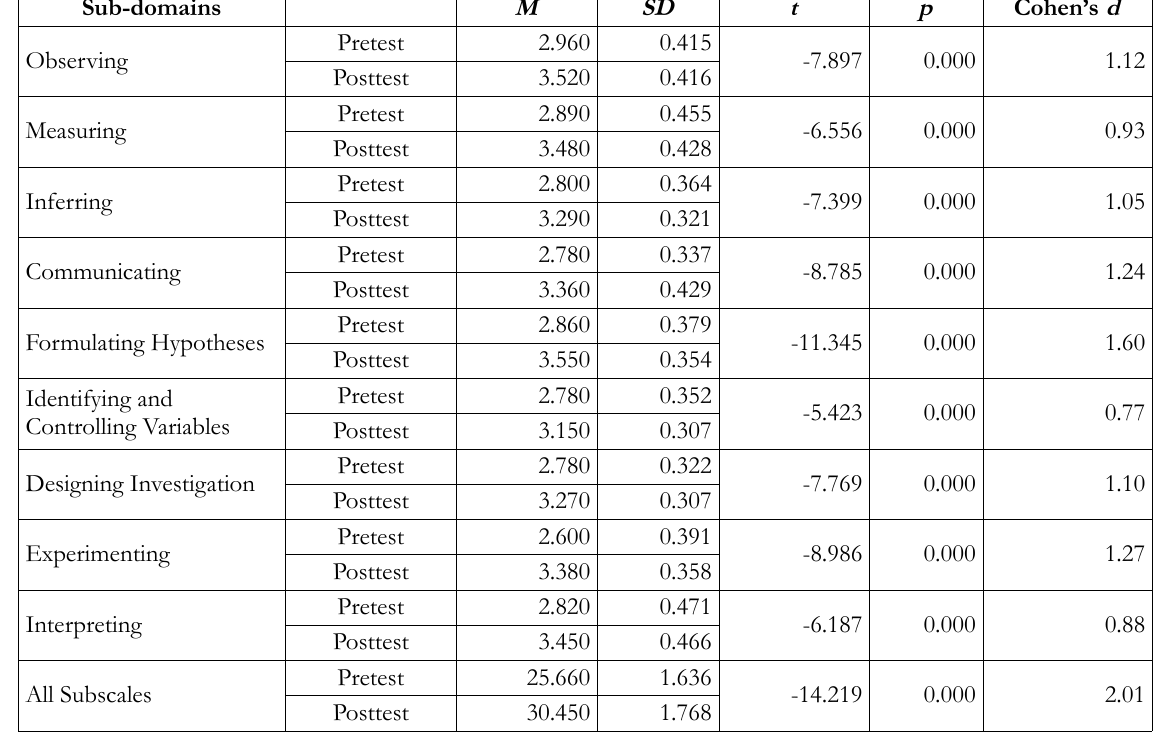
Table 1. Differences Between Pretest and Posttest Scores on